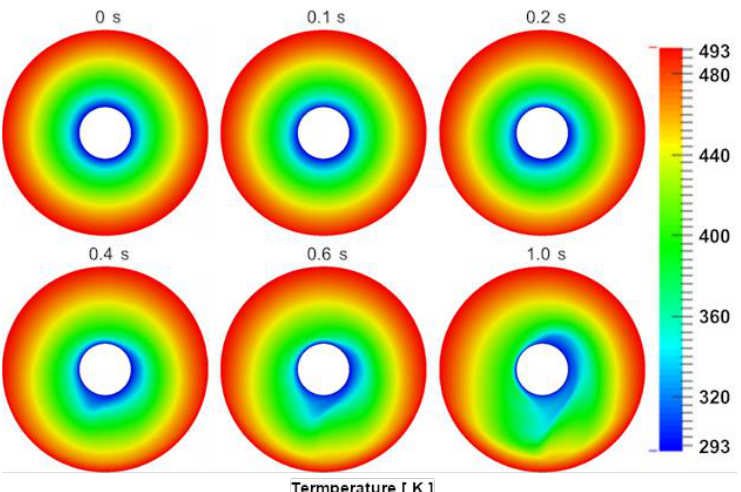
Figure 10. Temperature fields at different time steps predicted by the proposed particle flux model.